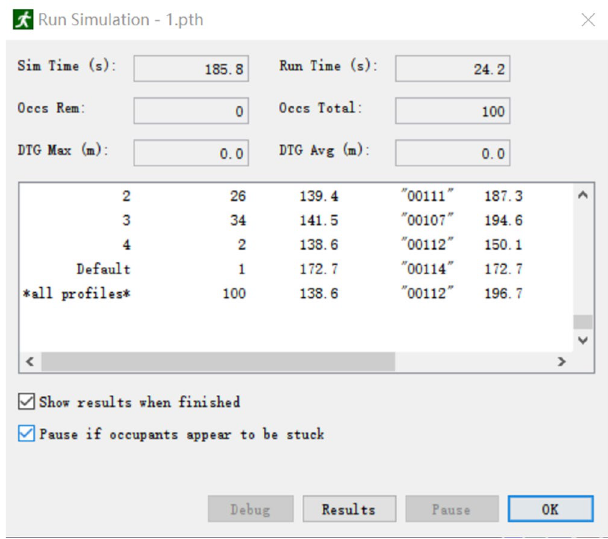
Figure 16. Total evacuation time.